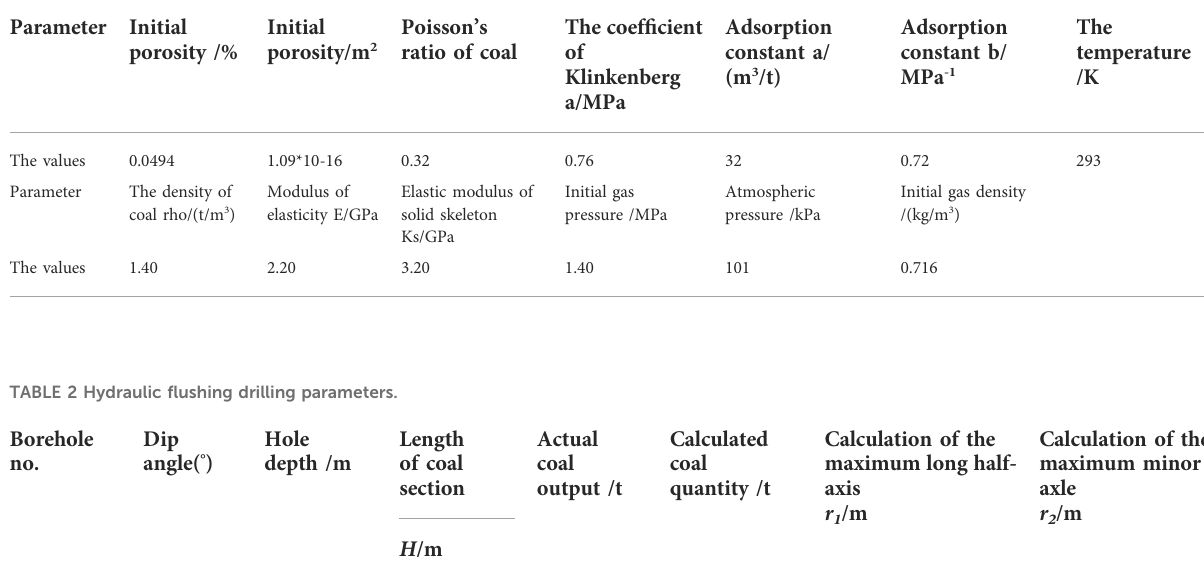
TABLE 1 Numerical model parameters.